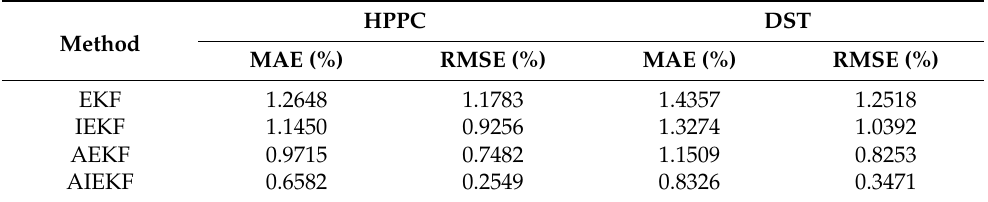
Table 1. Evaluation results of different SOC estimation methods under two operating conditions. Method